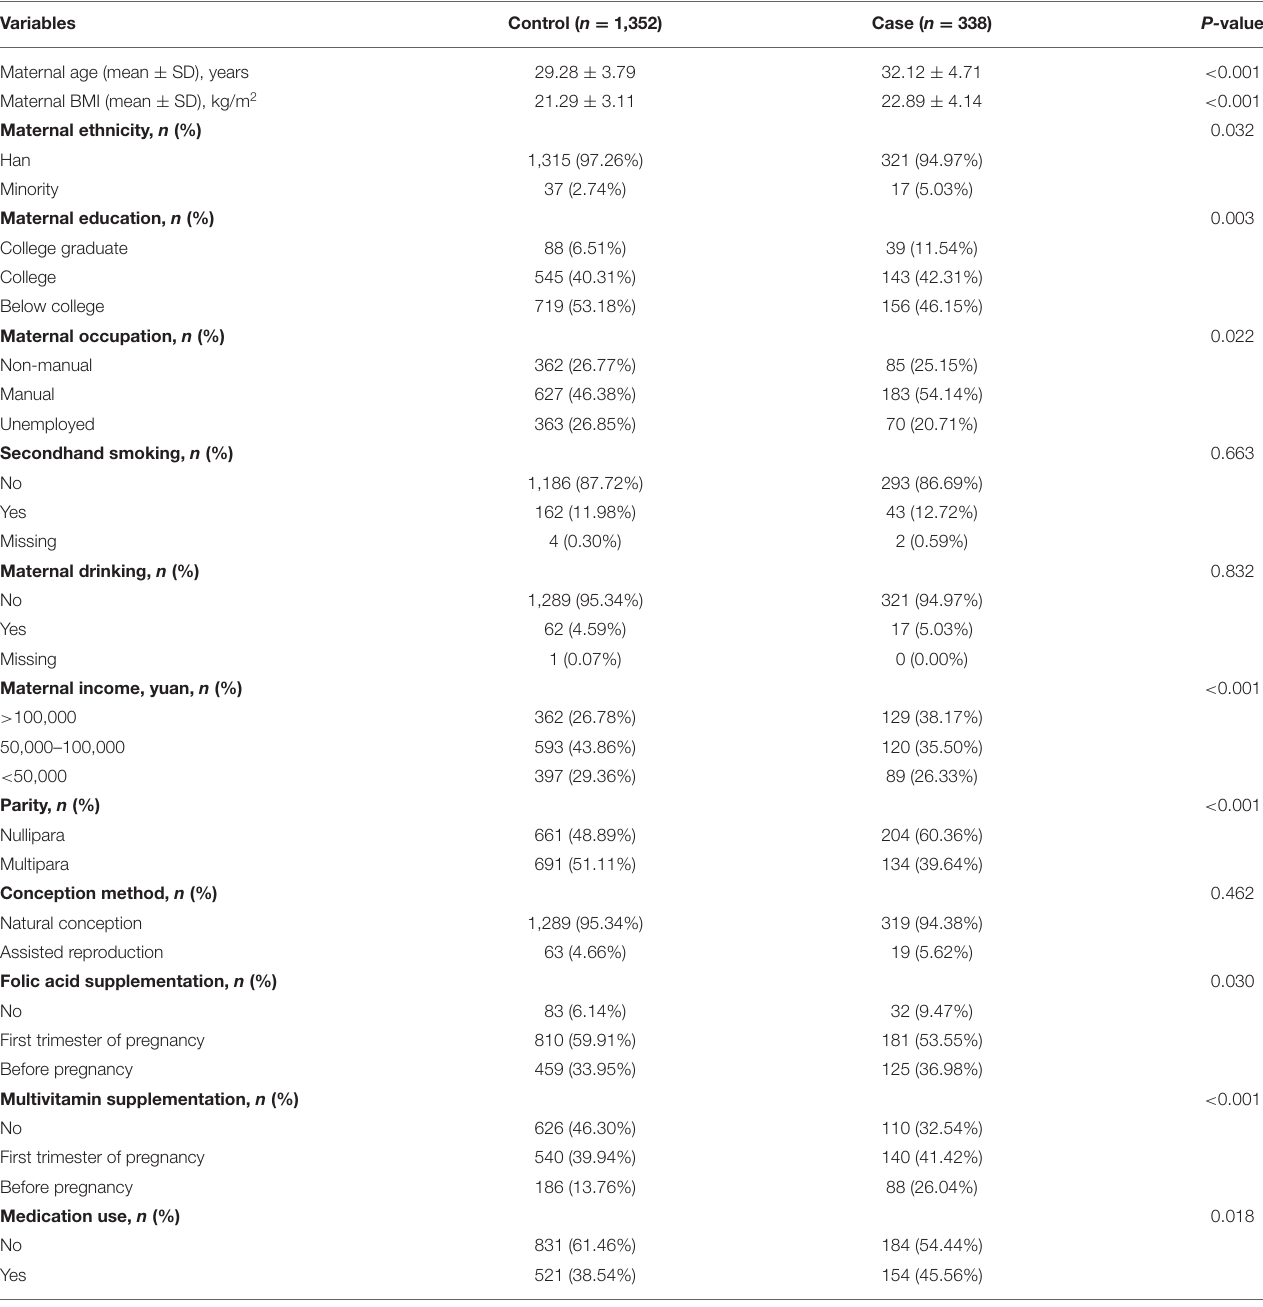
TABLE 1 | Study characteristics of cases and controls.